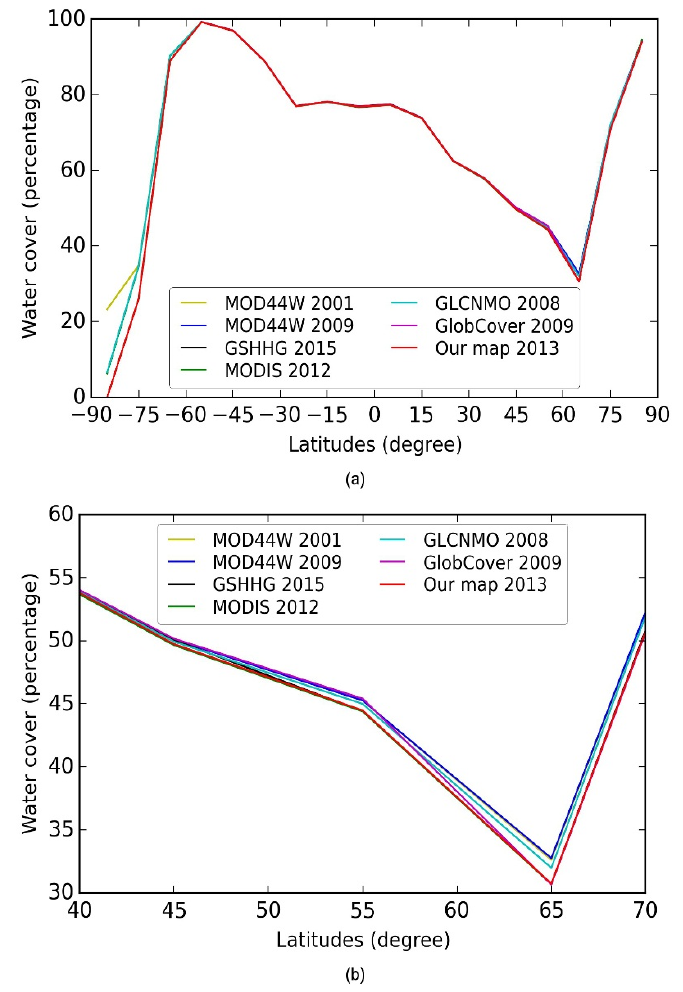
Figure 21. Variation of percentage water cover with respect to latitudes estimated by seven different maps. The results over the full latitudes in ( a ) are zoomed in to show details in (b ) between 40° and 70°